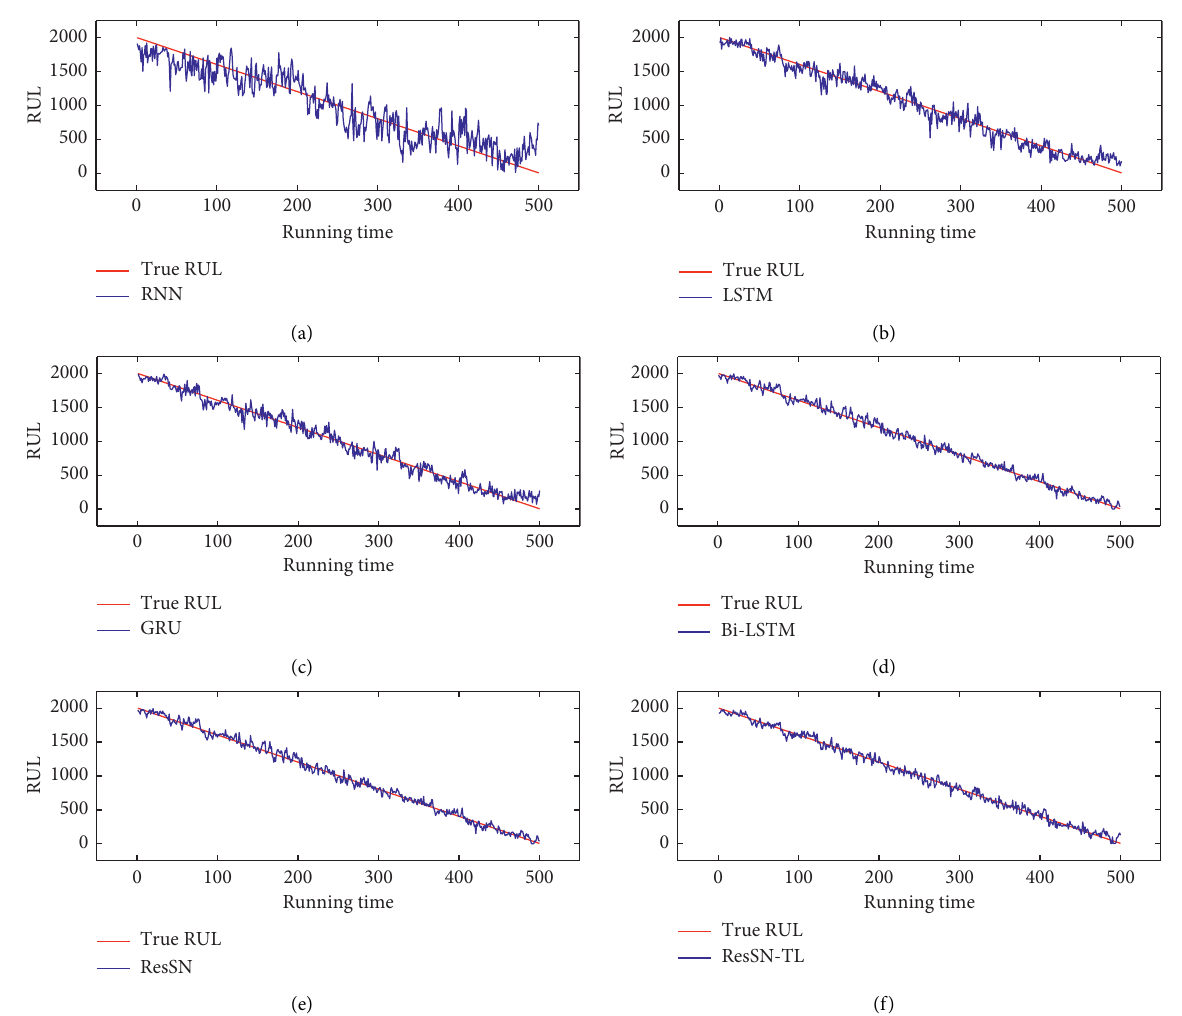
Figure 16: RUL prediction results of gearbox Data A, (a) RNN, (b) LSTM, (c) GRU, (d) Bi-LSTM, (e) ResSN, and (f)